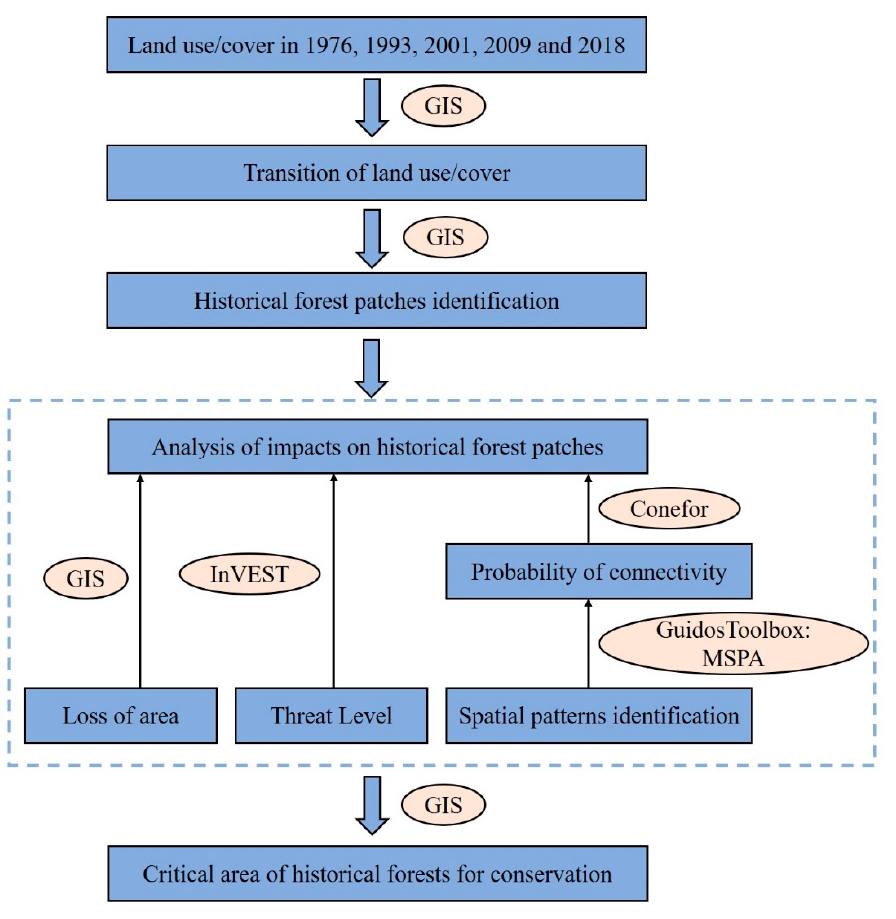
Figure 2. Workflow of the methods.